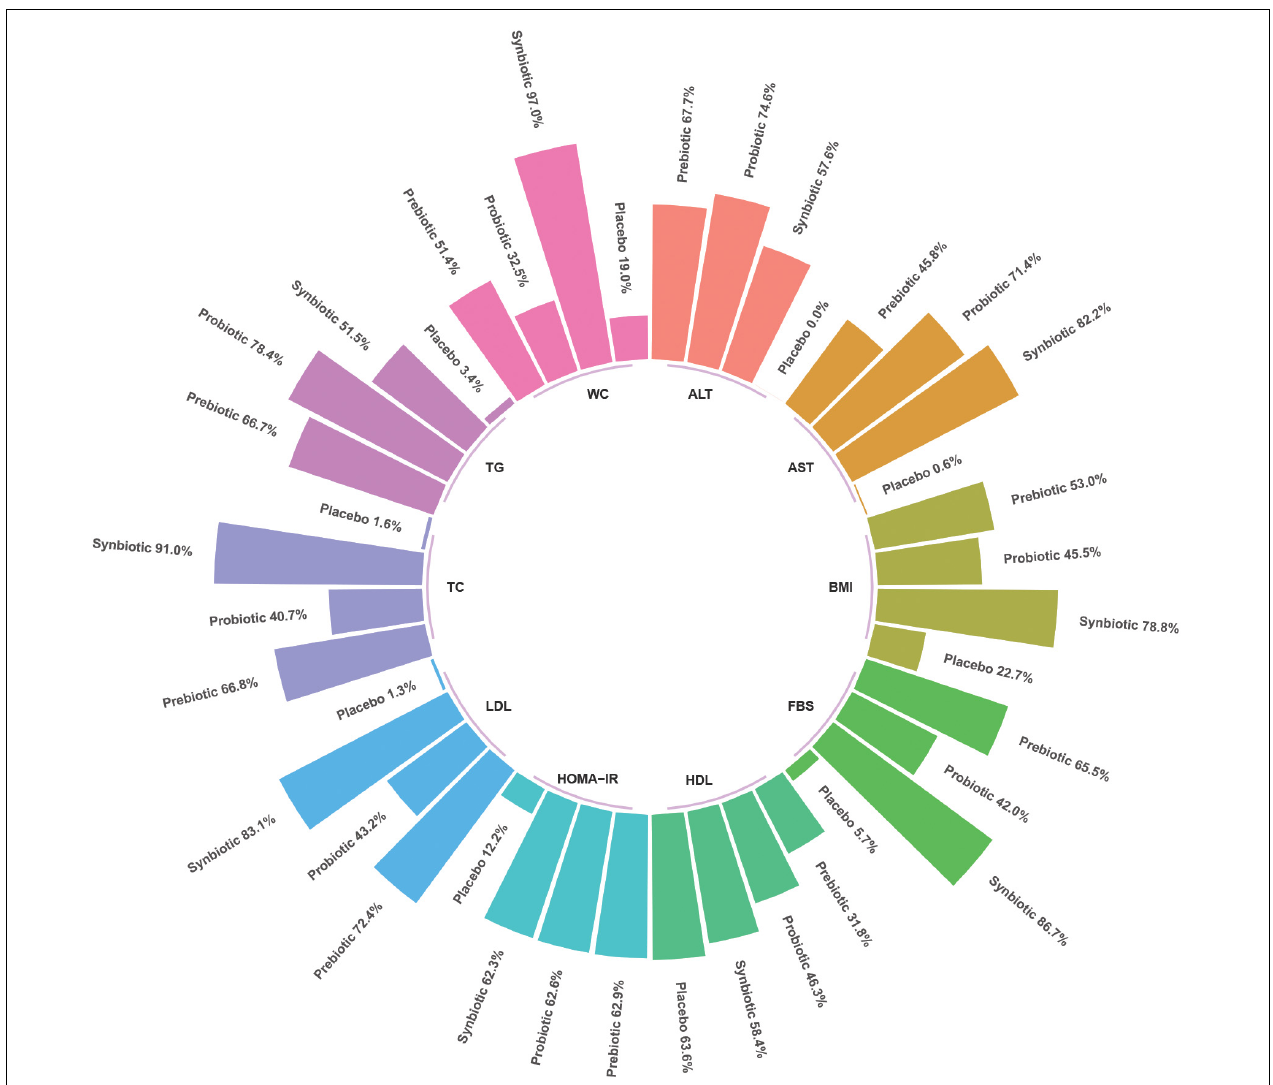
FIGURE 5 | Rank-bar chart with surface under the cumulative ranking (SUCRA) values for outcomes associated with synbiotics, probiotics, and prebiotics use in patients with non-alcoholic fatty liver disease